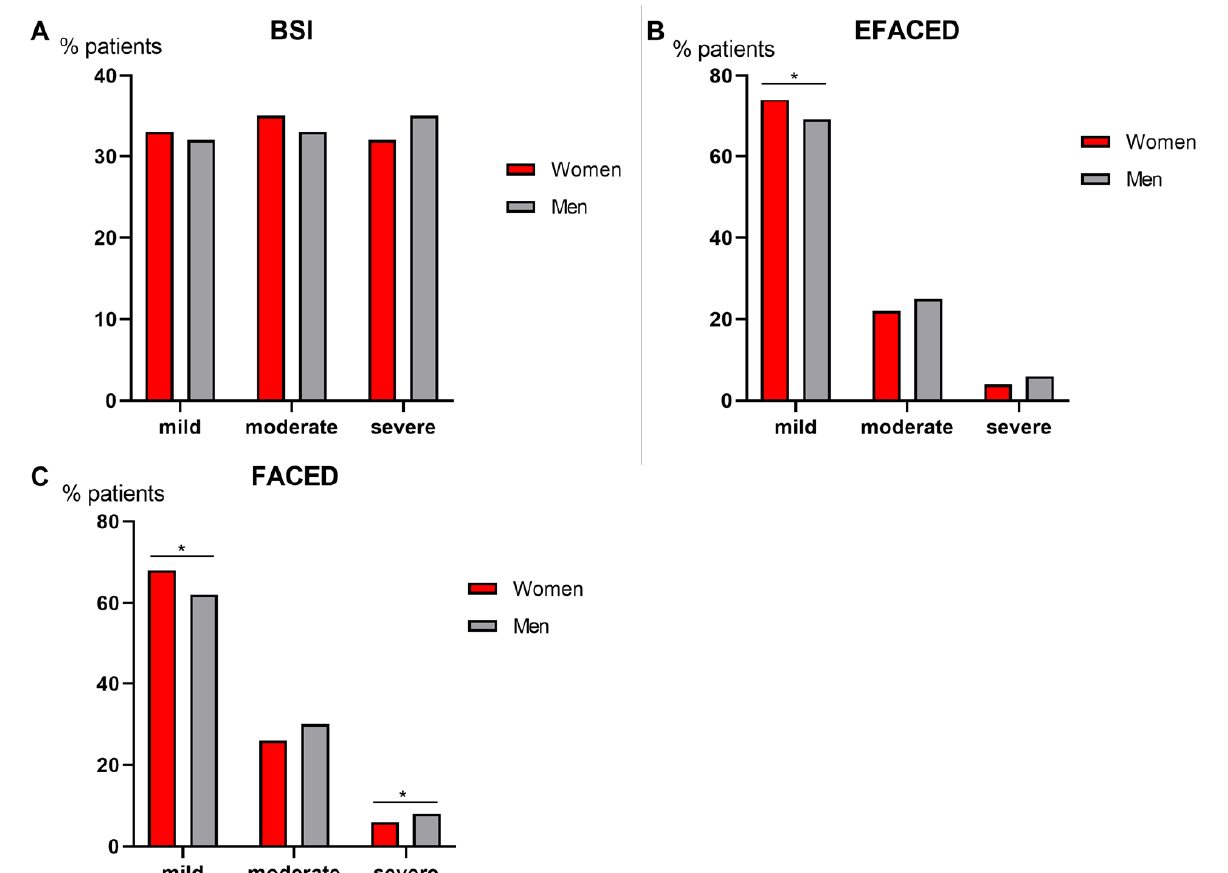
Figure 3. In bronchiectasis patients with no COPD, histograms of the proportions of patients who were classified as mild, moderate, or severe according to BSI ( A ), EFACED ( B ) and FACED ( C ) for both female (red color) and male (grey color) patients. Score subdivisions were as follows: (1) BSI: mild: 0–4, moderate: 5–8, severe: ≥ 9, (2) EFACED: mild: 0–3, moderate: 4–6, severe: 7–9; and (3) FACED: mild: 0–2, moderate: 3–4, severe: 5–7. Statistical significance: * p ≤ 0.05 between female and male patients for each score.